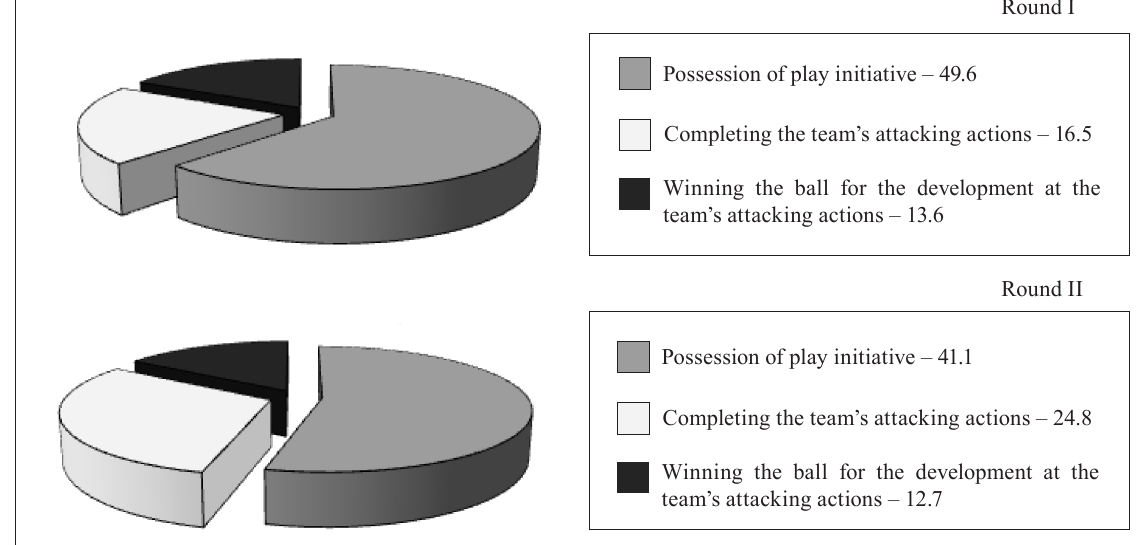
Figure. Important indices of competitive